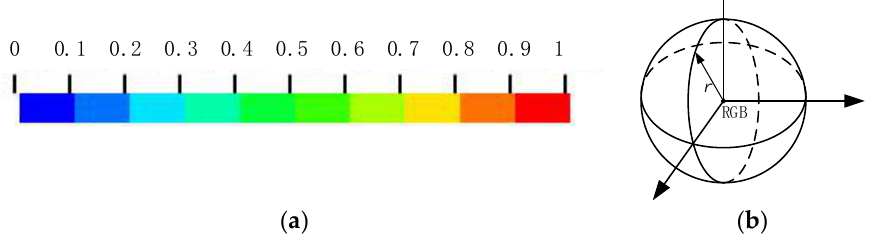
Figure 2. Quantitative analysis of rock damage: ( a ) the rock damage legend, ( b ) RGB values and channel values and pixel statistics.